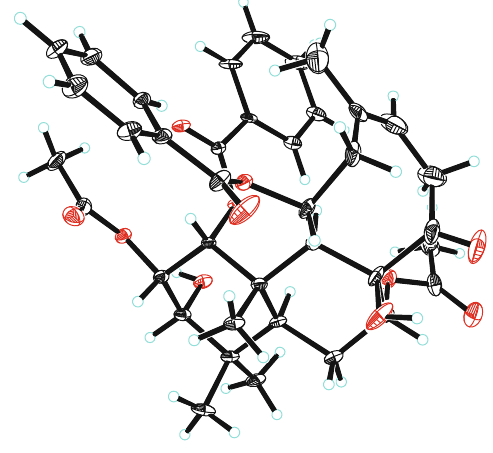
Fig. 4 The X-ray structure of